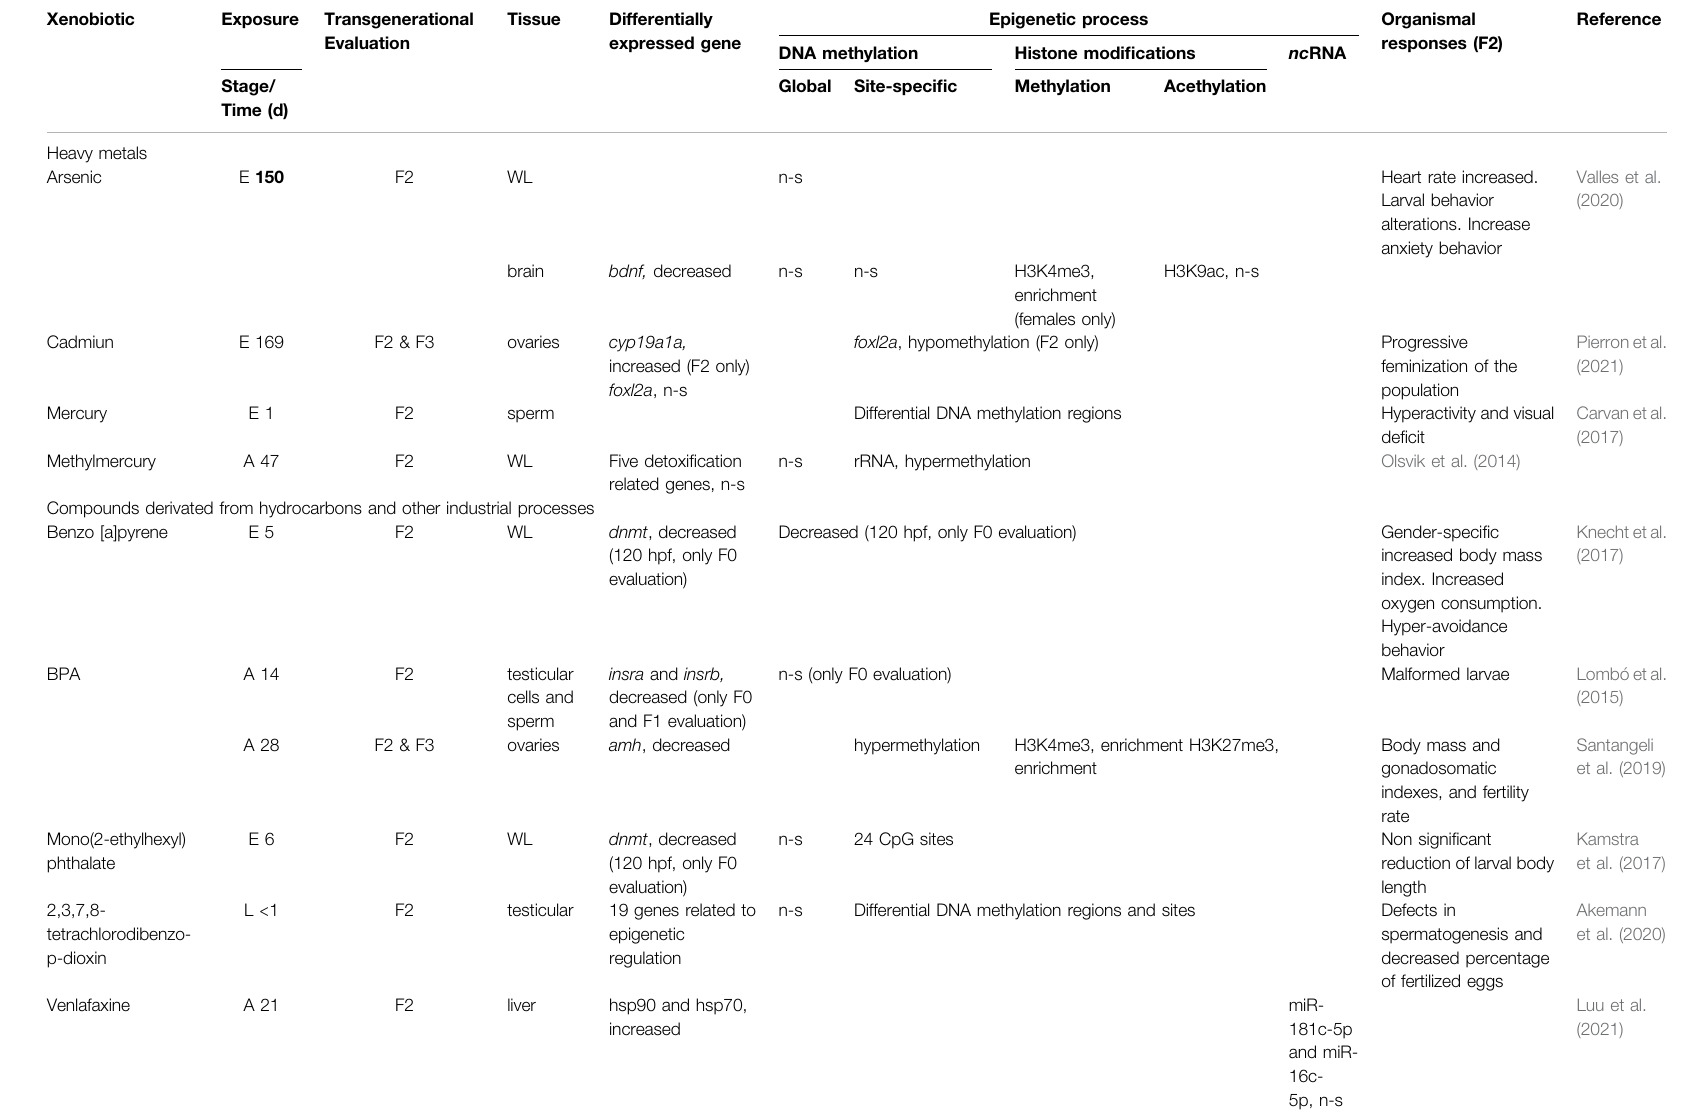
TABLE 1 | Xenobiotic exposure studies that include F2 and epigenetic approaches in zebra fi sh. A: adult, E: embryo, L: larvae exposure, WL: whole